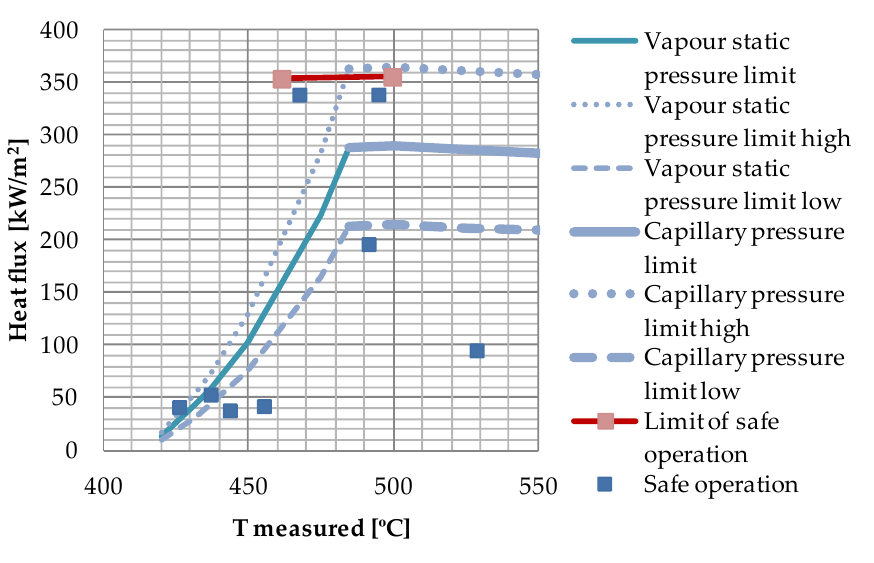
Figure 6. Wick performance data for wick height 11.2 cm. Dots represent experimental data. Red dots—at maximum performance limit; blue dots—safe operation.